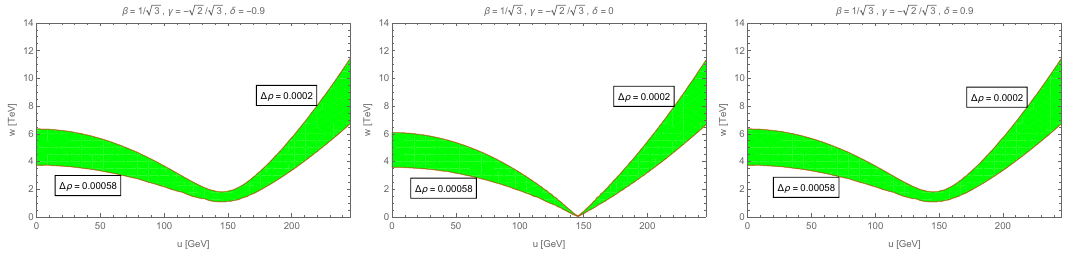
Figure 4 . The ( u, w ) regime that is bounded by the ρ parameter for ( β = 1 / √ 3 , γ = −√ 2 / √ 3 , b = 2 / √ 3, c = −√ 2 / √ 3) and w = 0 . 5Λ − and 0 . 9, respectively.